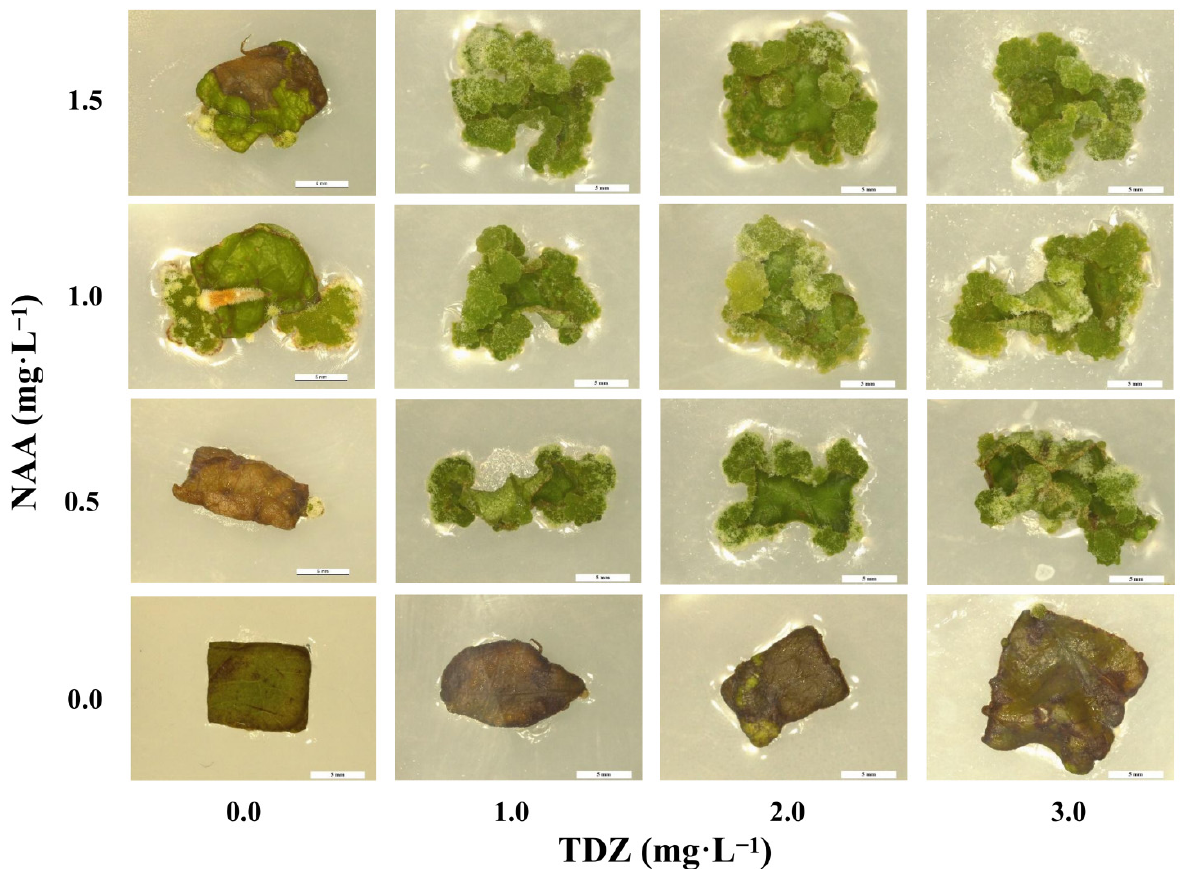
Figure 1. Morphology of the calli induced from the leaf explant of Cotoneaster wilsonii . Bars indicate 5 mm.